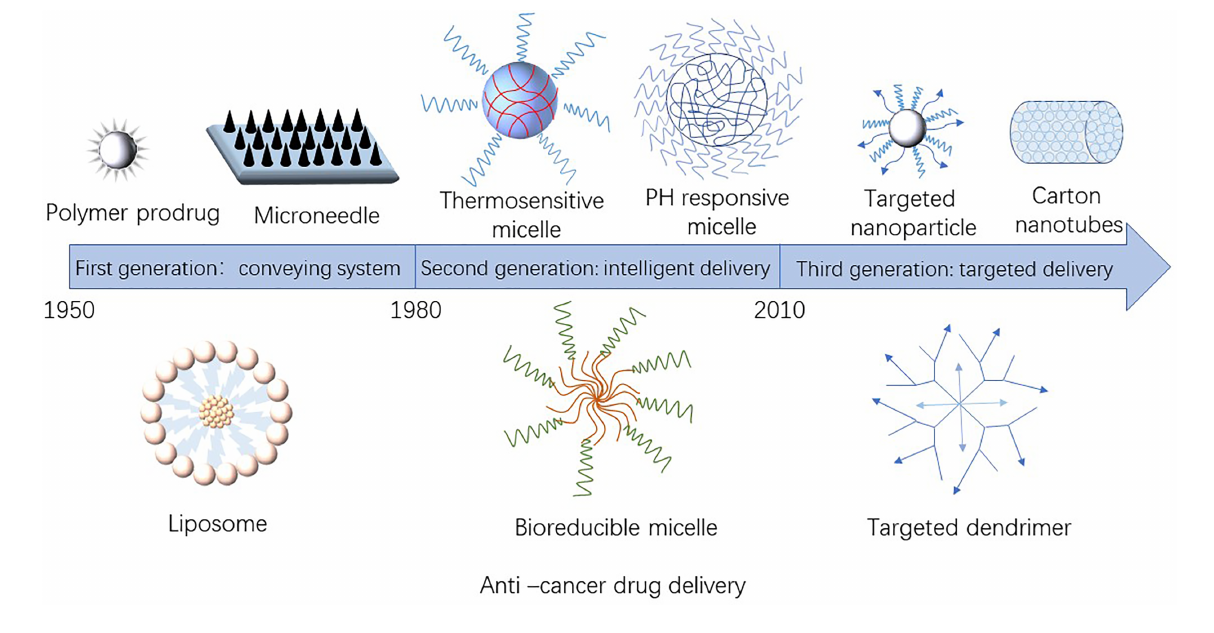
FIGURE 1 | Development of nano-carriers for anti-tumor drug.